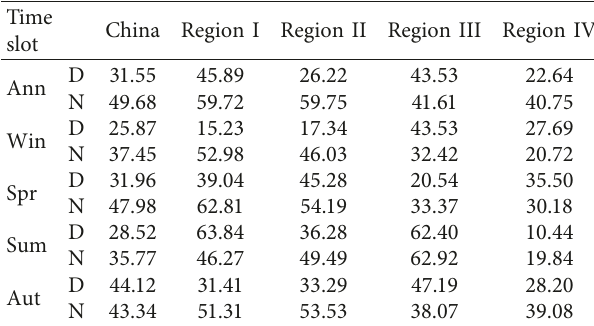
Table 2: Explanation rates of daytime and nighttime SUHII in China and in the four regions annually for four seasons